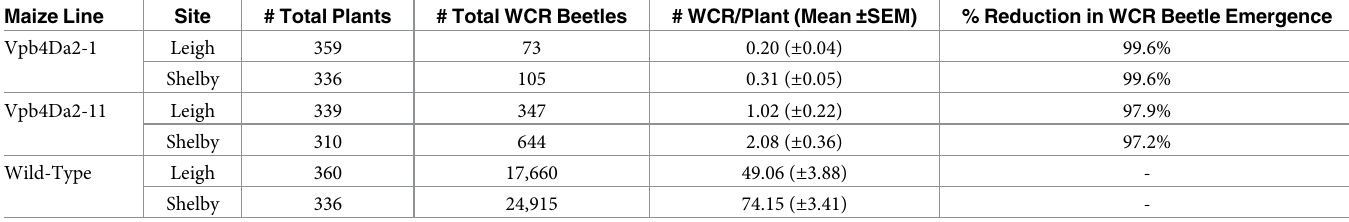
Emergence of WCR beetles in tents planted with Vpb4Da2 transgenic maize lines and wild-type control maize in 2017 field at Leigh, NE, and Shelby, NE. Two Vpb4Da2 transgenic lines represent the protein root expression at high (Vpb4Da2-1) and low (Vpb2Da2-11) levels,